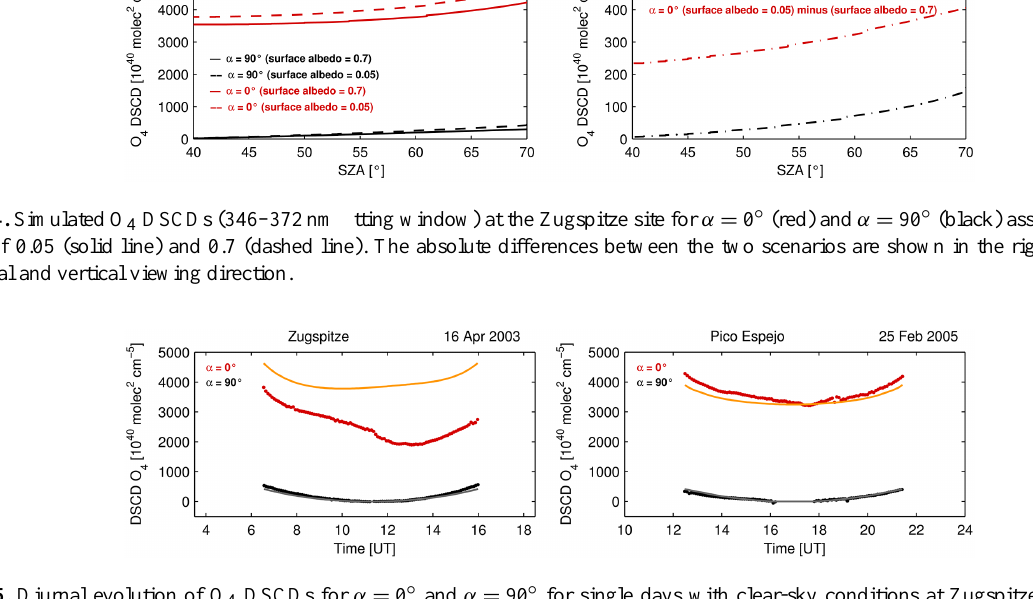
Figure 5. Diurnal evolution of O 4 DSCDs for α = 0 ◦ and α = 90 ◦ for single days with clear-sky conditions at Zugspitze (left) and Pico Espejo (right). Here, O 4 DSCDs are retrieved from measured (red and black lines for α = 0 ◦ and α = 90 ◦ , respectively) and synthetic (orange and gray lines for α = 0 ◦ and α = 90 ◦ , respectively) spectra in the 346–372nm fitting window and only shown for SZAs<70 ◦ (see Sect.